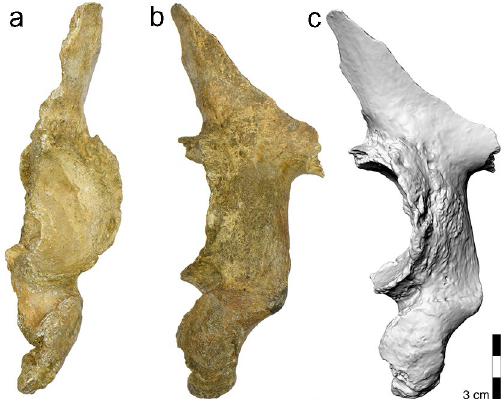
Figure 8. The partial left hipbone of La Chapelle-aux-Saints 1. ( a ) photograph in lateral view, ( b ) posterior view. ( c ) 3D surface scan, oblique posterior view. Note the presence of erosions and new bone formation that extends far beyond the hip joint. This does not occur in osteoarthritis, but is compatible with extra-articular granulomas in